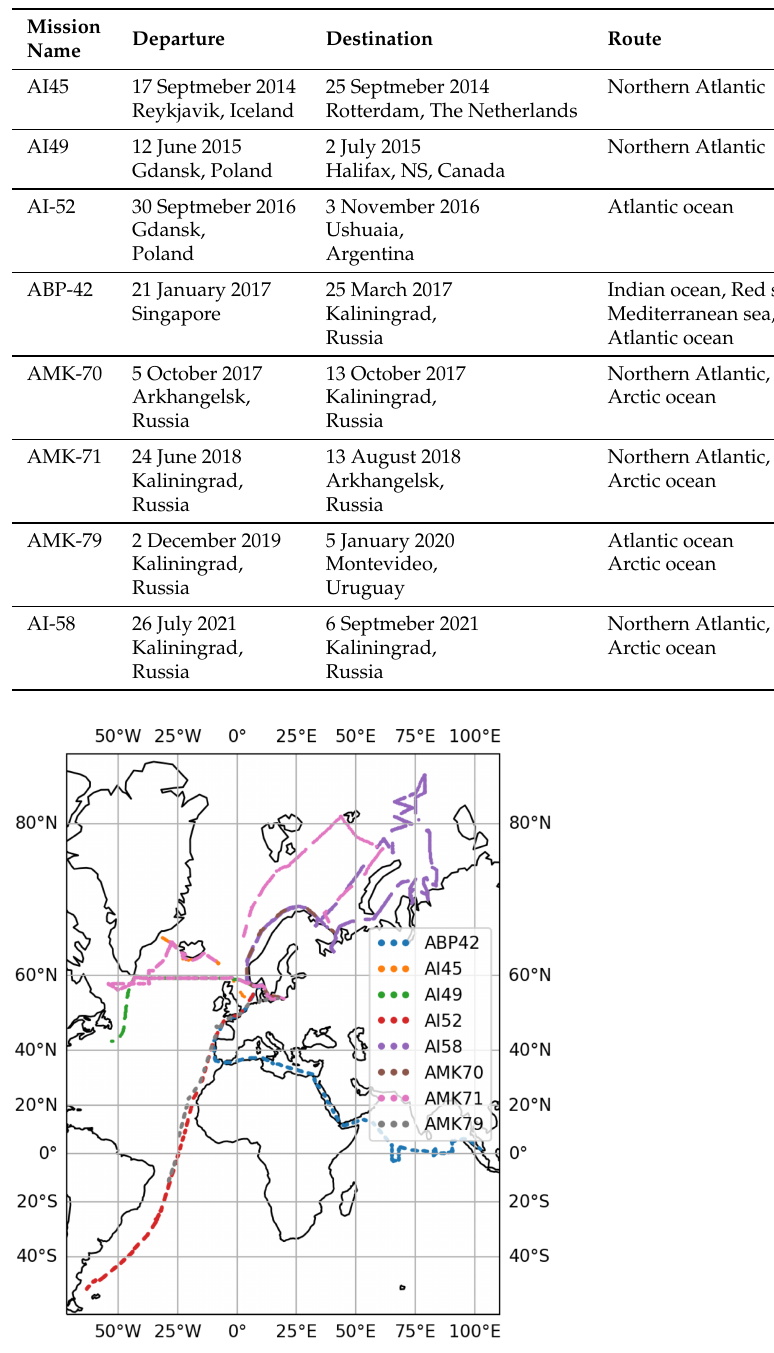
Table 3. Scientific missions resulting in the DASIO collection of all-sky imagery over the ocean with the corresponding expert records of meteorological parameters.